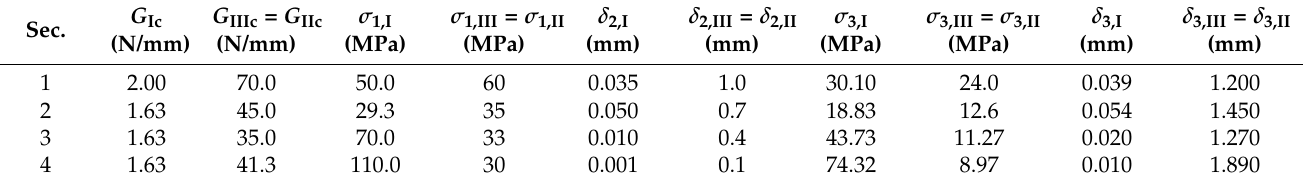
Table 2. Parameters of the cohesive mixed-mode (I+II) law obtained in pull-out